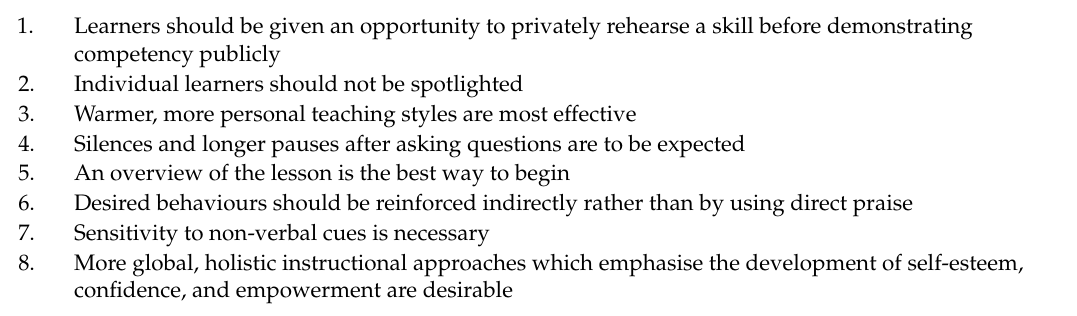
Table 4. General Guidelines for Teaching Indigenous Students cited from Ledoux (2006)